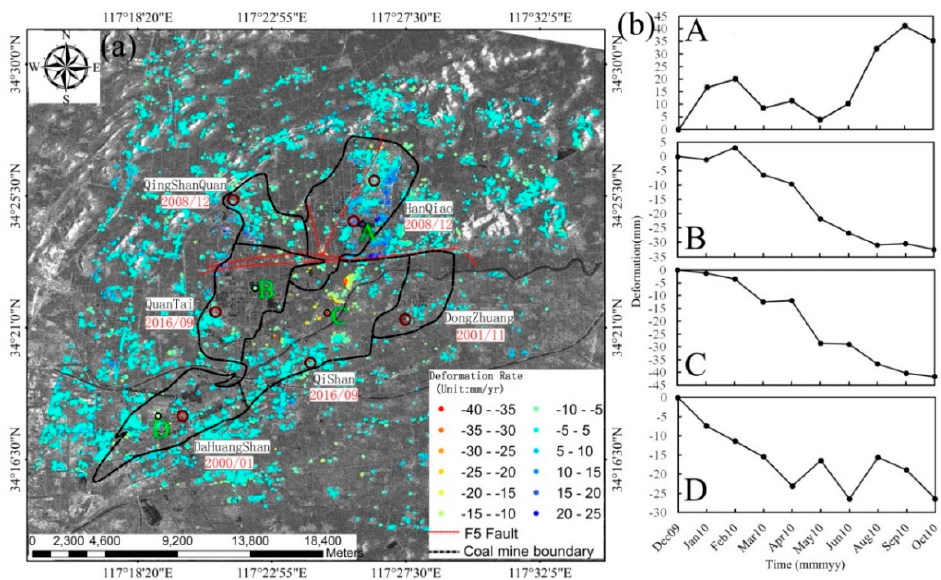
Figure 4. The LOS deformation from December 2009 to October 2010. ( a ) The LOS annual average deformation rate. The red-black circles are the locations of the main wells in the mining area. The black circles show the location of the pixels whose time-series are showed in ( b ), and the base map is the intensity image of ENVISAT obtained on 16 March 2010. ( b ) The LOS time-series deformation.